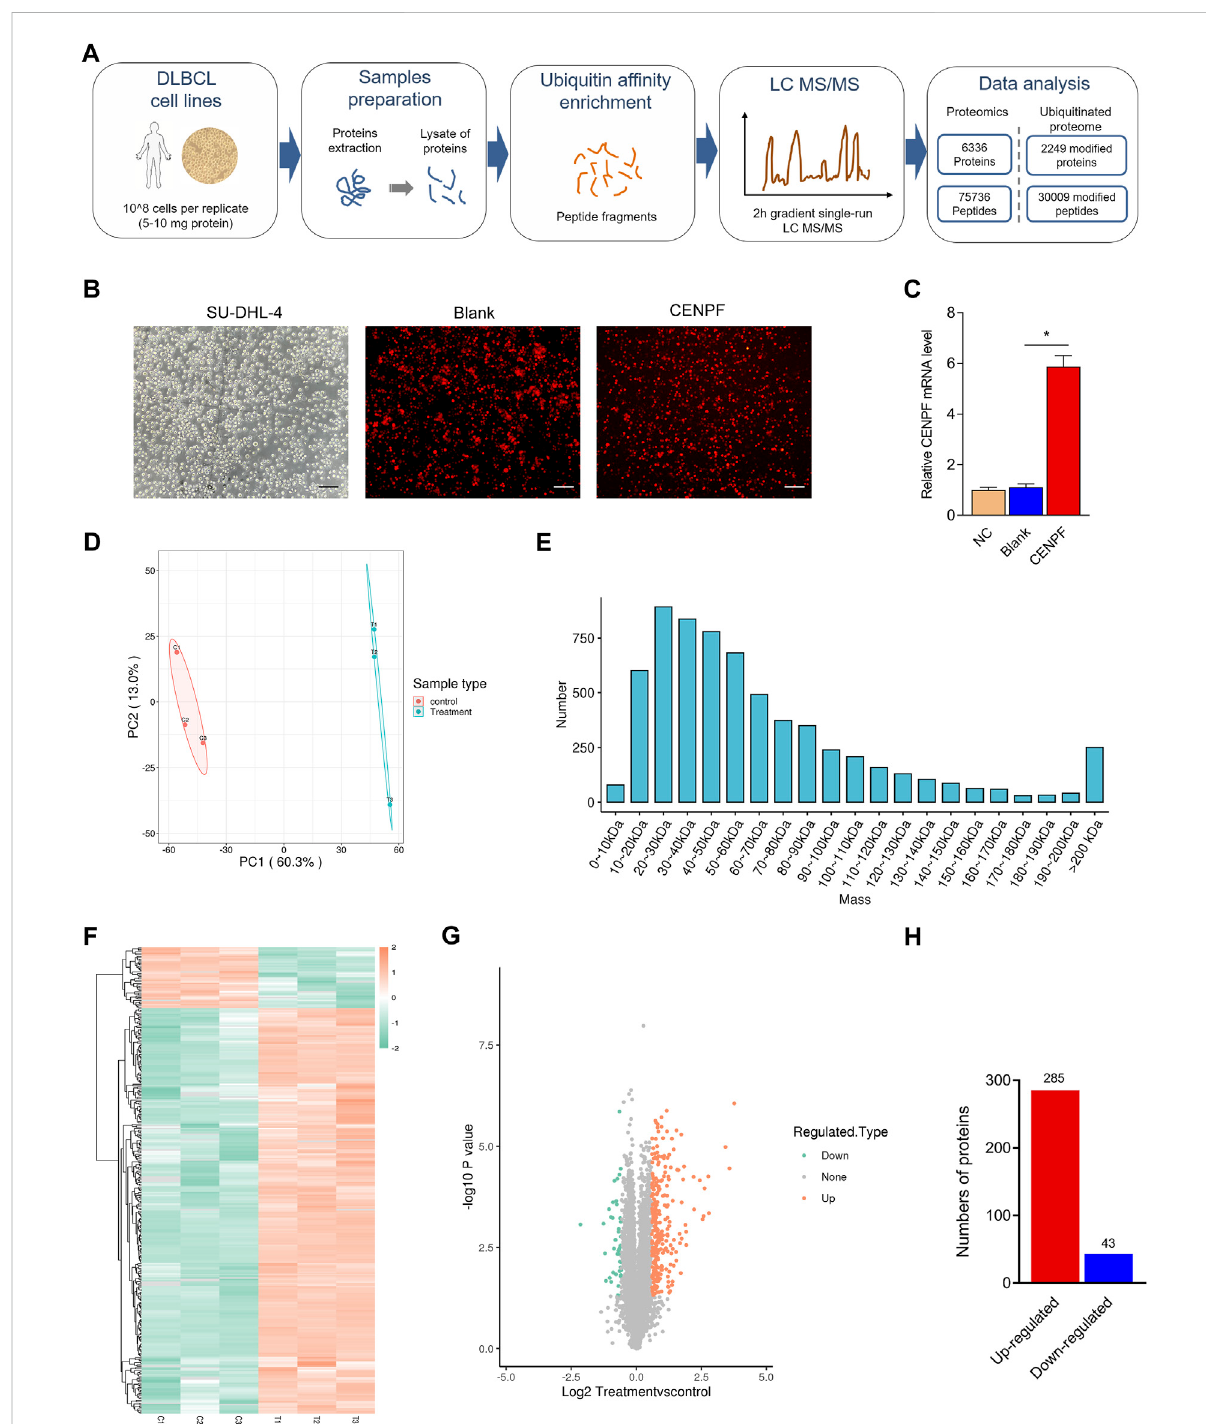
FIGURE 2 Quantitative proteomic pro fi ling analysis in CENPF-upregulated DLBCL cells (A) . Flowcharts of the quantitative proteome and ubiquitinome analysis in CENPF-overexpressing DLBCL cells; (B) . The expression of CENPF in a DLBCL cell line (SU-DHL-4) was upregulated using an adenovirus and evaluated under a fl uorescence microscope; scale bar is 100 μ m; (C) . Quantitative analysis of CENPF expression in different groups of SU-DHL- 4 cells; (D) . The results of principal component analysis in the control group and CENPF-upregulated group; (E) . The numbers of proteins with different molecular masses determined by proteome analysis in DLBCL cells; f-g. The results of clustering analysis by proteome analysis are presented as a heatmap and volcano plots (log2-fold change and – log10 p value). (H) . The numbers of upregulated and downregulated proteins identi fi ed by quantitative